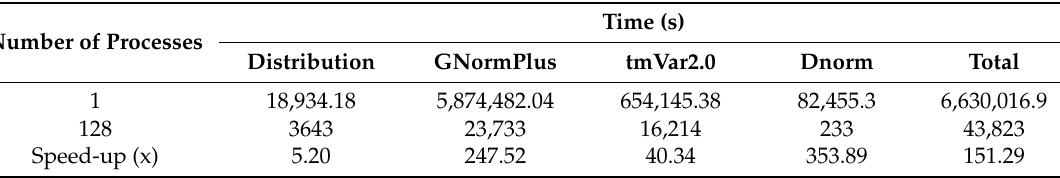
Table 5. The processing time of 61,078 papers running on 128 processes.